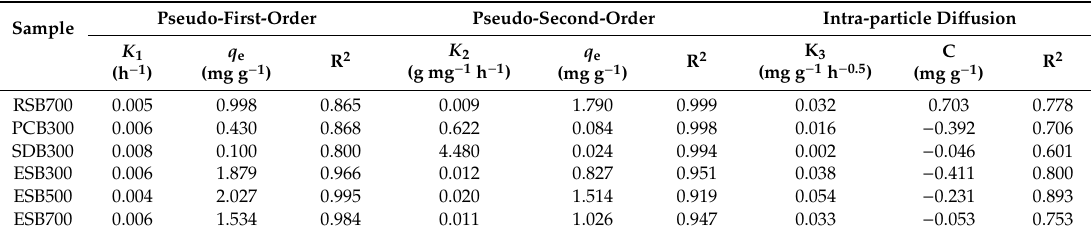
Table 2. Parameters of P adsorption kinetics of di ff erent biochars.